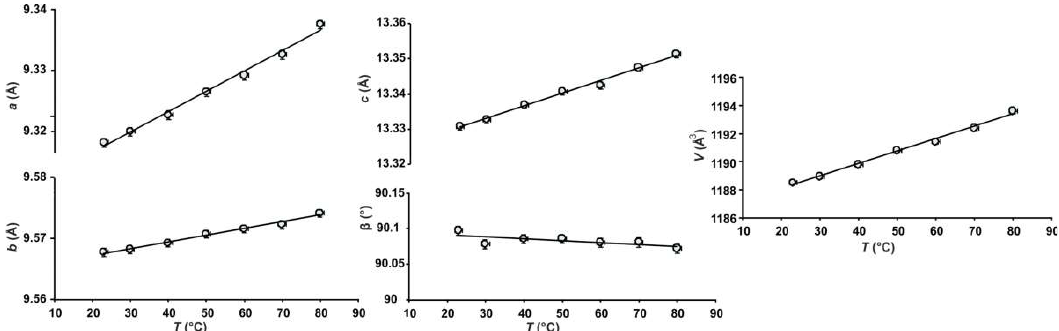
Figure 4. The dependencies of the unit-cell parameters versus temperature for NH 4 MgCl 3 ·6H 2 O phase.